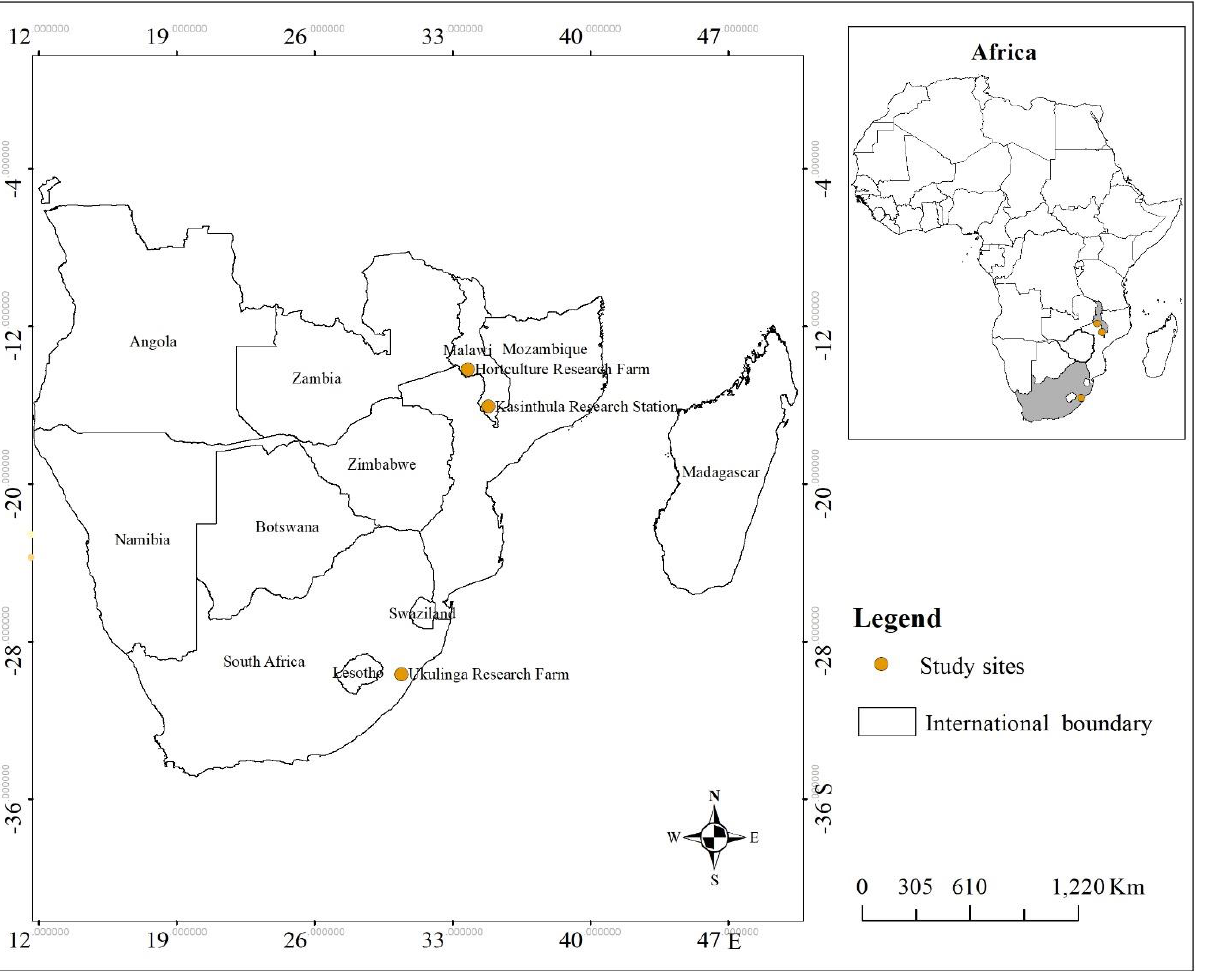
Figure 1. Map of the study sites in Malawi and germplasm source in South Africa. Table 1. Description of the study sites.